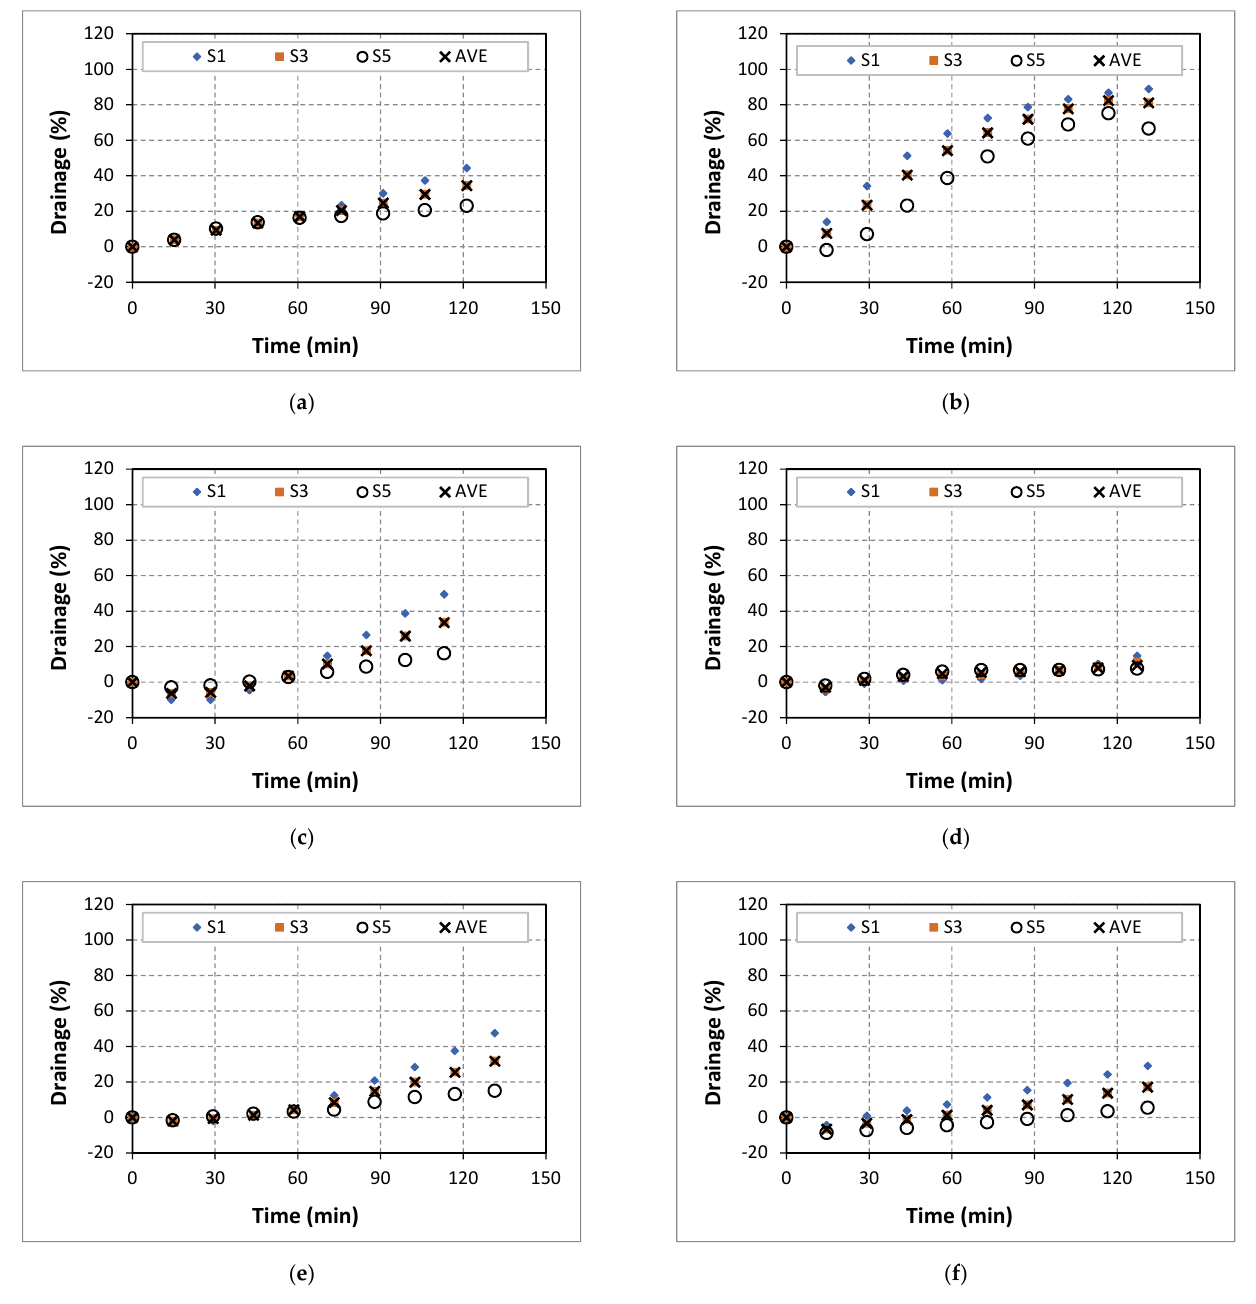
Figure A2. Drainage of 60% quality aqueous foam at different NaCl concentrations: ( a ) 0% wt., ( b ) 5% wt., ( c ) 7% wt., ( d ) 9% wt., ( e ) 14% wt., and ( f ) 18% wt.